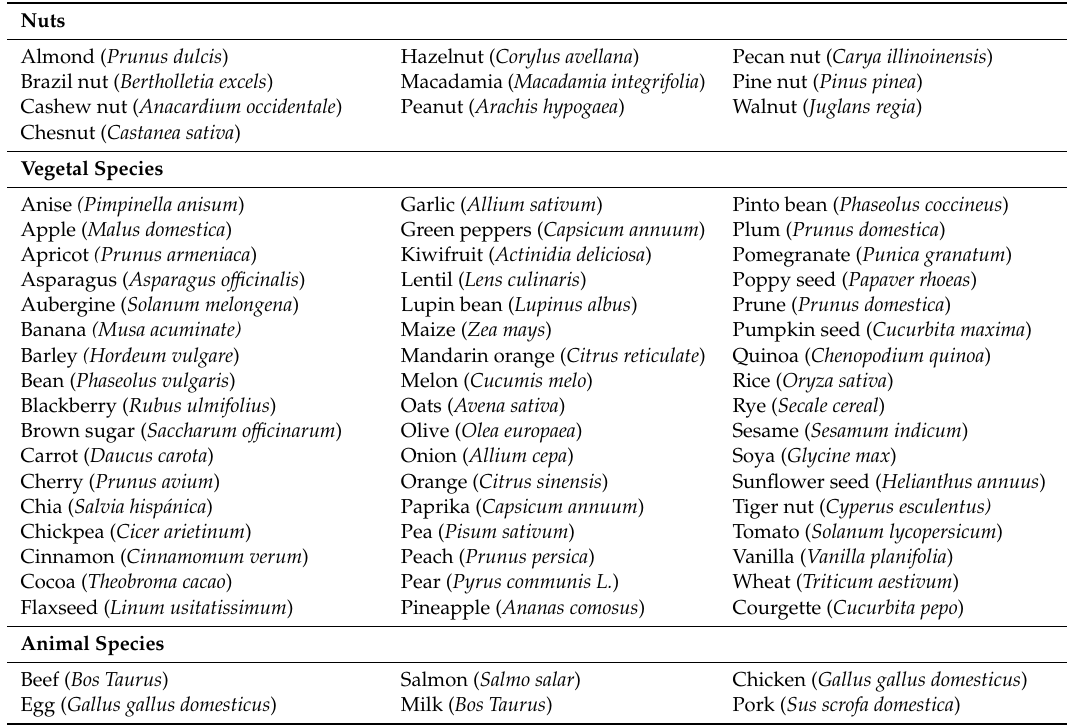
Table 1. List of heterologous species analysed in the indirect phage enzyme-linked immunosorbent assay